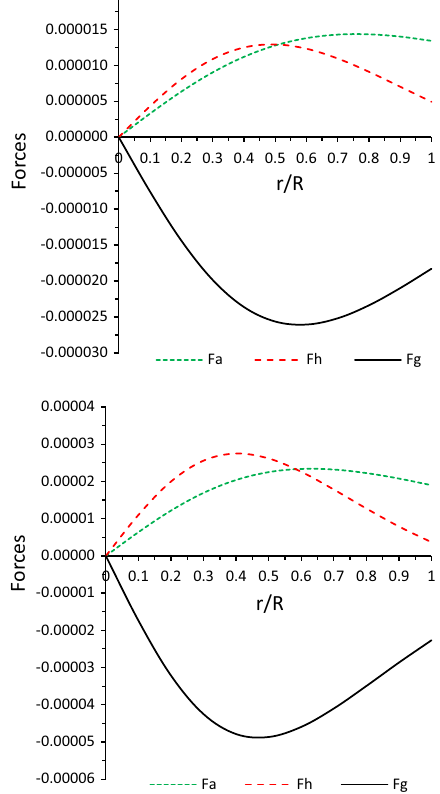
Fig. 11 Behaviour of different forces vs. fractional radius r / R for LMC X-4 ( top left ), EXO 1785-248 ( top right ), PSR J1903+327 ( bot- tom left ) and 4U 1820-30 ( bottom right ). For plotting this figure the numerical values of physical parameters and constants are as follows: (i) a = 0 . 004, b = 0 . 0021, c = 0 . 0107, A = 0 . 4806, B = 1 . 2607, M = 1 . 29 M (cid:7) , and R = 8 . 831 km for LMC X-4, (ii) a = 0 . 00393,